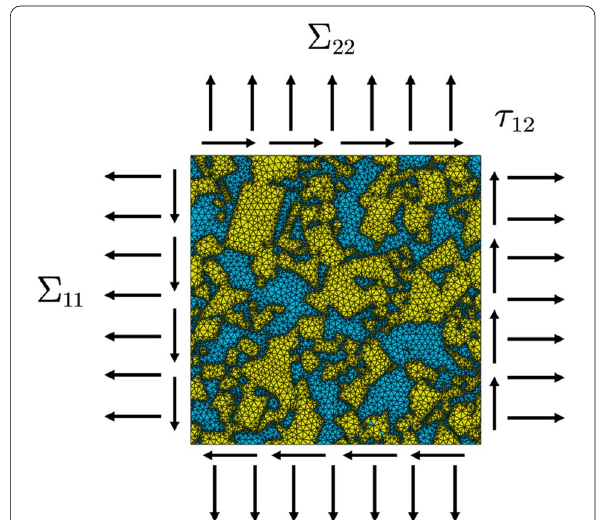
Figure 4 FE mesh and load conditions for SERVE